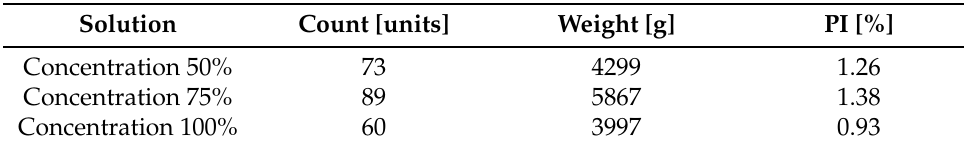
Figure 19. Cumulative PI time curves of the three plots. The curves are the PIs with 50% diluted dosage (blue), 75% diluted dosage (green), and non-diluted dosage (orange). Table 3. Count, weight, and PI comparison